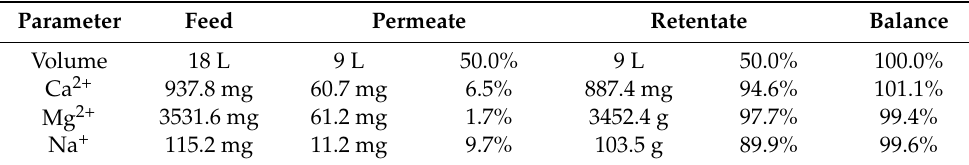
Table 6. Mass balance of the RO process for the ESPA-2540